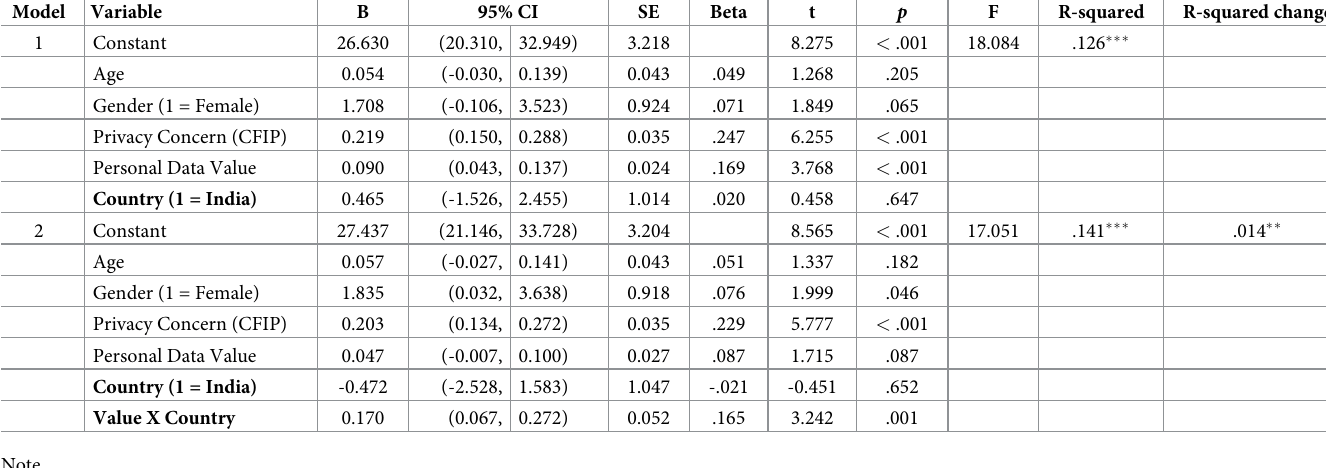
Table 4. Regression analysis predicting privacy behaviour from demographic variables, privacy concern, mean-centred personal data value, and country (India or USA), Study 1b. Model